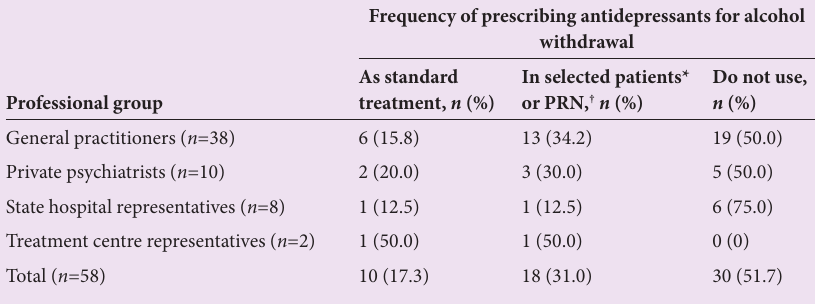
Table 4. Routine prescription of antidepressants by different professional groups during alcohol withdrawal